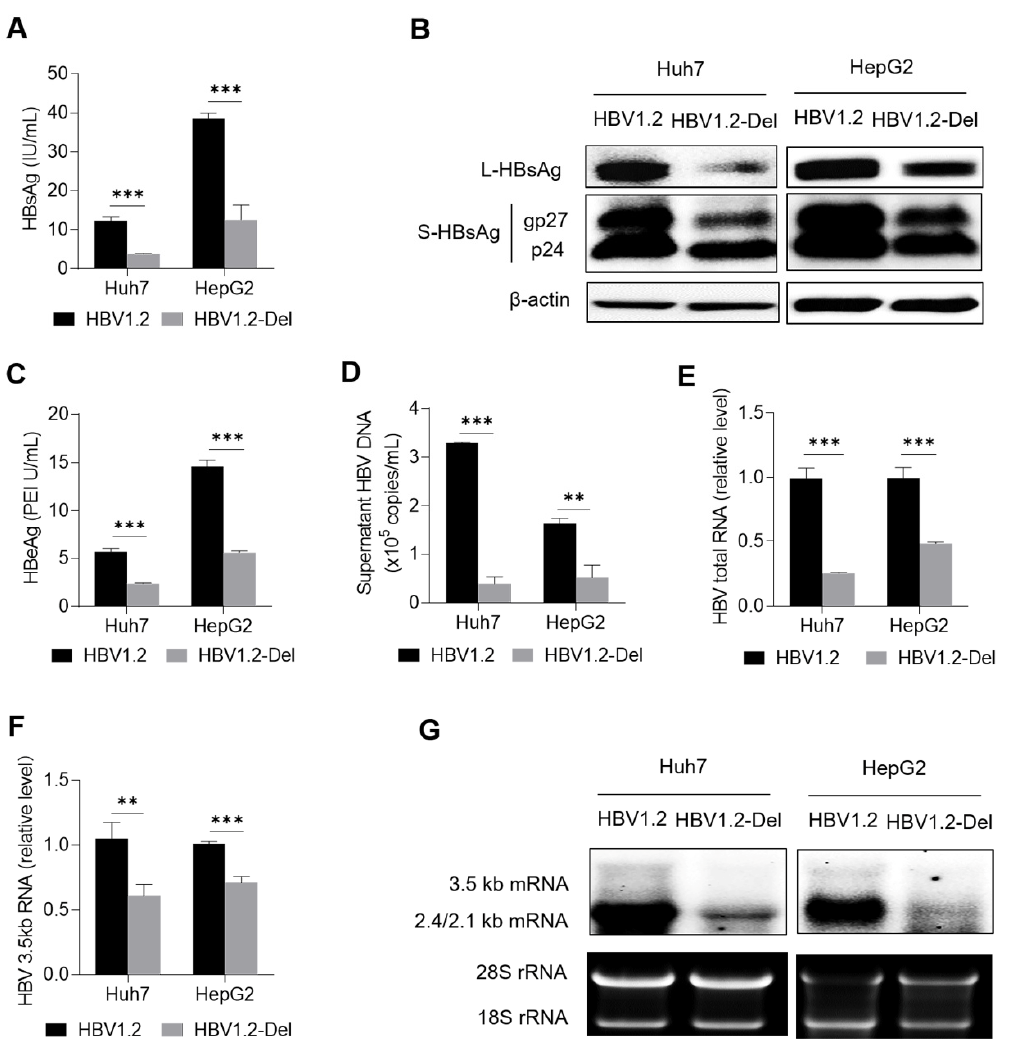
Figure 2. The effect of x128–133del on HBV replication. The pBB4.5-HBV1.2 or pBB4.5-HBV1.2-Del plasmid and pCDH-Nluc plasmid were co-transfected into the Huh7 and HepG2 cells (5 × 10 5 cells/well in a 6-well plate). Cell culture supernatants and cells were harvested at 72 h after transfection. ( A ) The level of HBsAg in the cell culture supernatants was detected by the chemiluminescence immunoassay. ( B ) The intracellular levels of large HBsAg (L-HBsAg) and small HBsAg (S-HBsAg) including gp27 and p24 proteins were detected by Western blot. The β -actin protein was used as the internal control. ( C ) The level of HBeAg in the cell culture supernatants was detected by the chemiluminescence immunoassay. ( D ) The level of supernatant HBV DNA was detected by qPCR. The levels of intracellular HBV total RNA ( E ) and 3.5 kb RNA ( F ) were detected by RT-qPCR. The ACTB mRNA was used as the internal control. ( G ) The levels of intracellular HBV mRNAs including HBV 3.5 kb, 2.4 kb, and 2.1 kb RNAs were detected by Northern blot. The 28s and 18s rRNAs were used as the internal control. ** p < 0.01, *** p < 0.001, Student’s t- test.